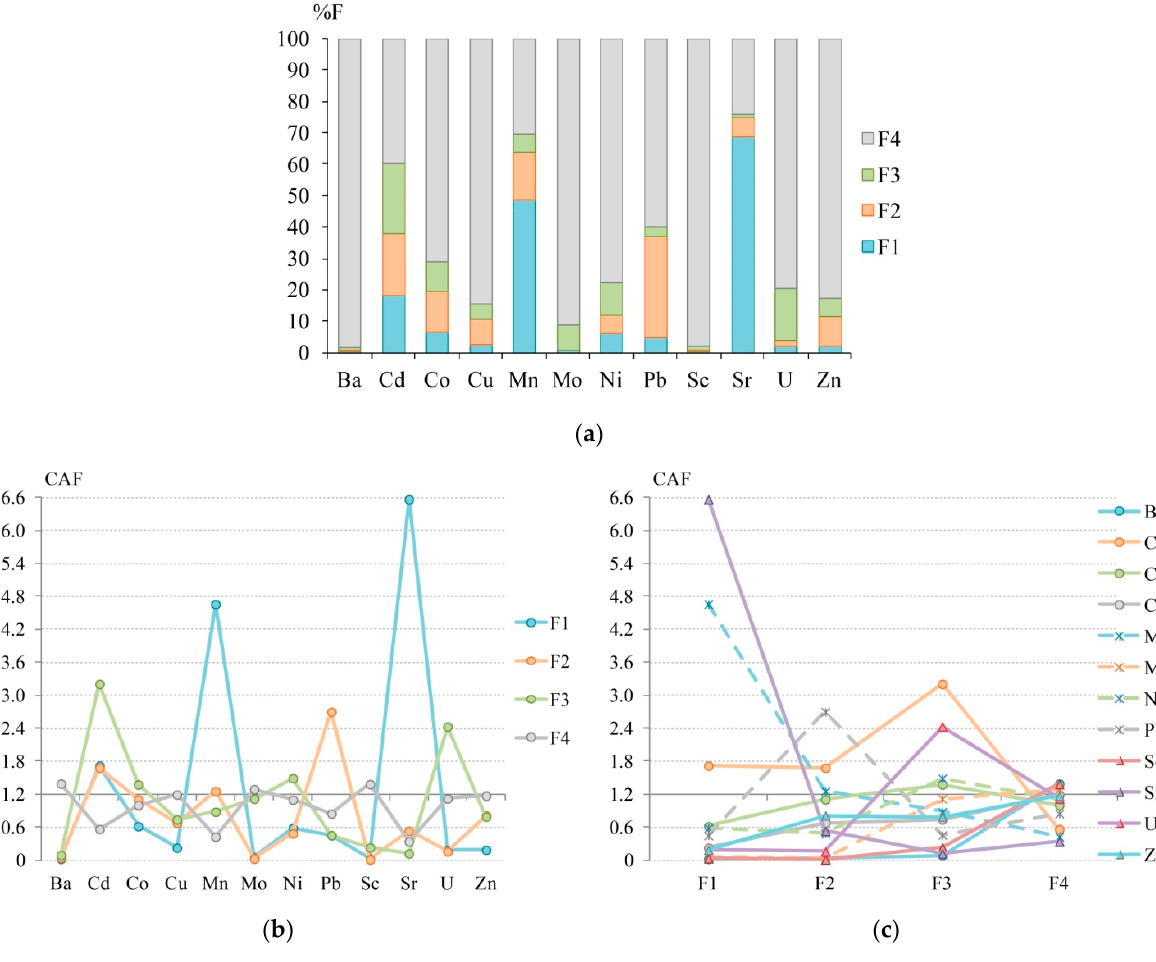
Figure 2. The fractionation distribution of HMs ( a ), levels of chemical affinity factor (CAF) for HMs ( b ), and levels of CAF for chemical fractions ( c ) in surface sediments of Daya Bay—calculated from the data of X. Gao et al. [111]. F1—acid-soluble (exchangeable and bound to carbonates), F2—reducible (bound to Fe/Mn oxides), F3—oxidizable (bound to organic matter and sulfides), F4—residual (metals within lithogenic minerals) fraction.